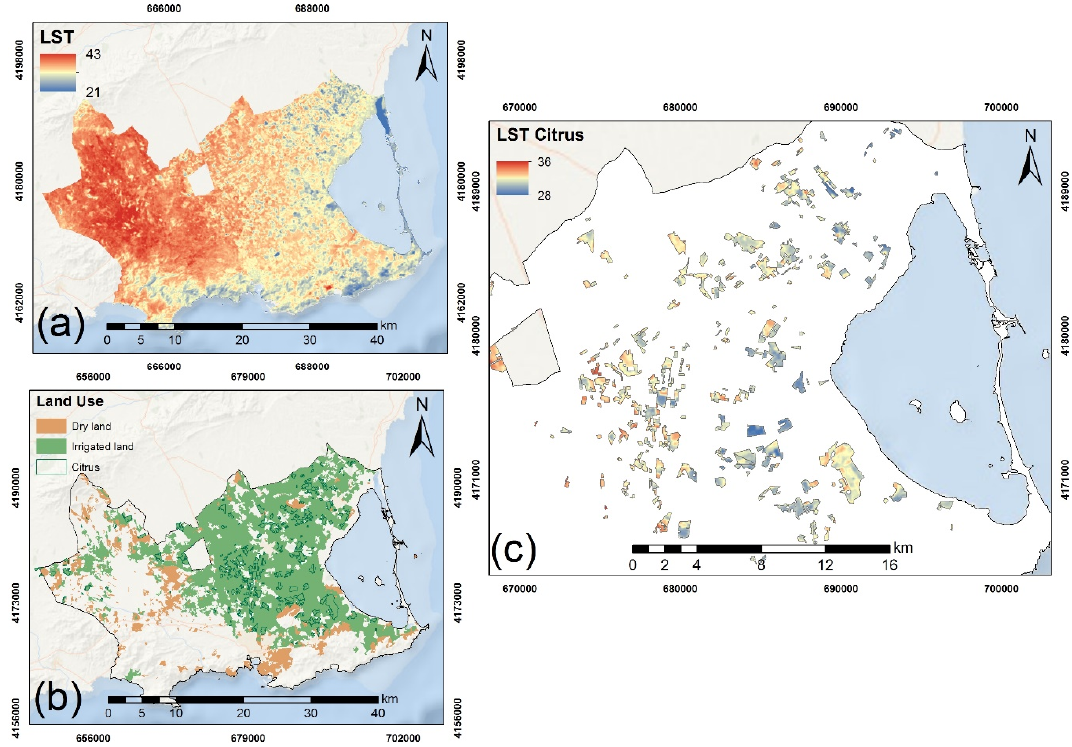
Figure 2. Land surface temperature (LST; °C) retrieved at the regional scale (a); agricultural land uses (b); and LST (°C) in citrus plots (c) at Campo de Cartagena. Data were obtained following [51], [56], respectively.